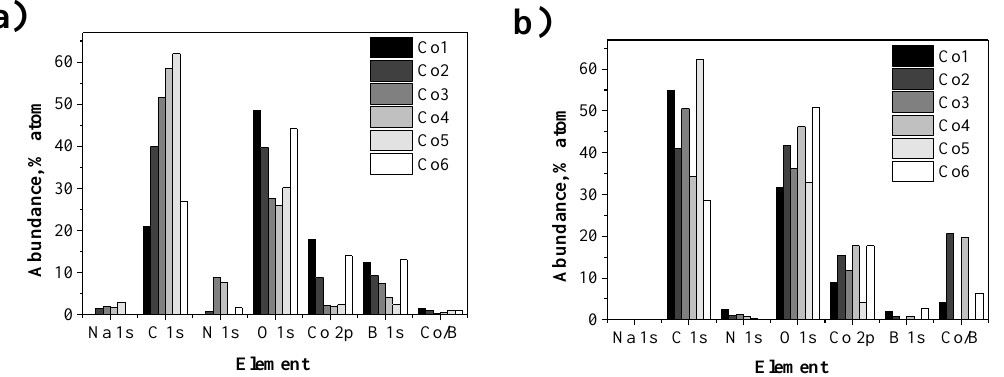
Figure 6. Surface elemental composition of ( a ) fresh and ( b ) used catalysts after AFTS determined by XPS analysis.